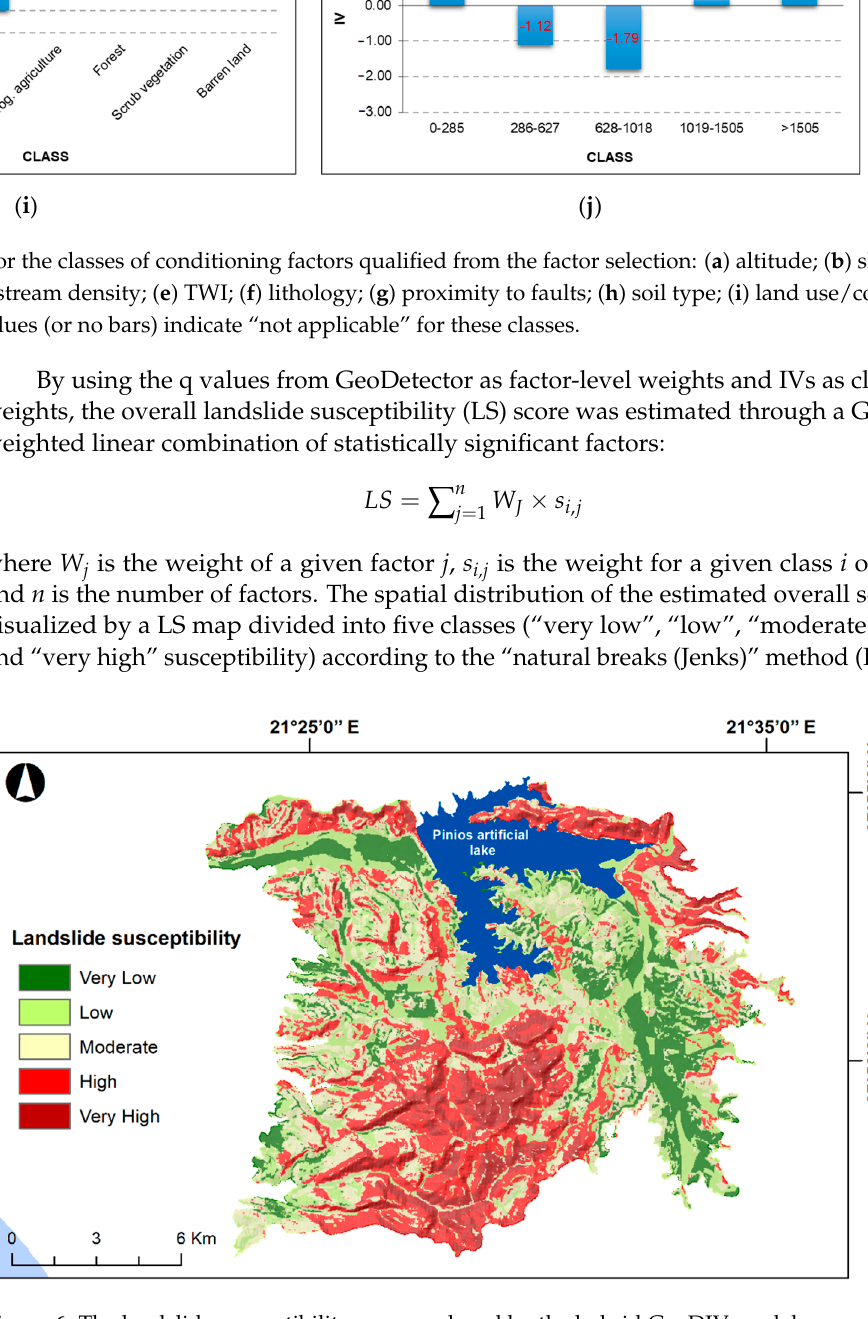
Figure 6. The landslide susceptibility map produced by the hybrid GeoDIV